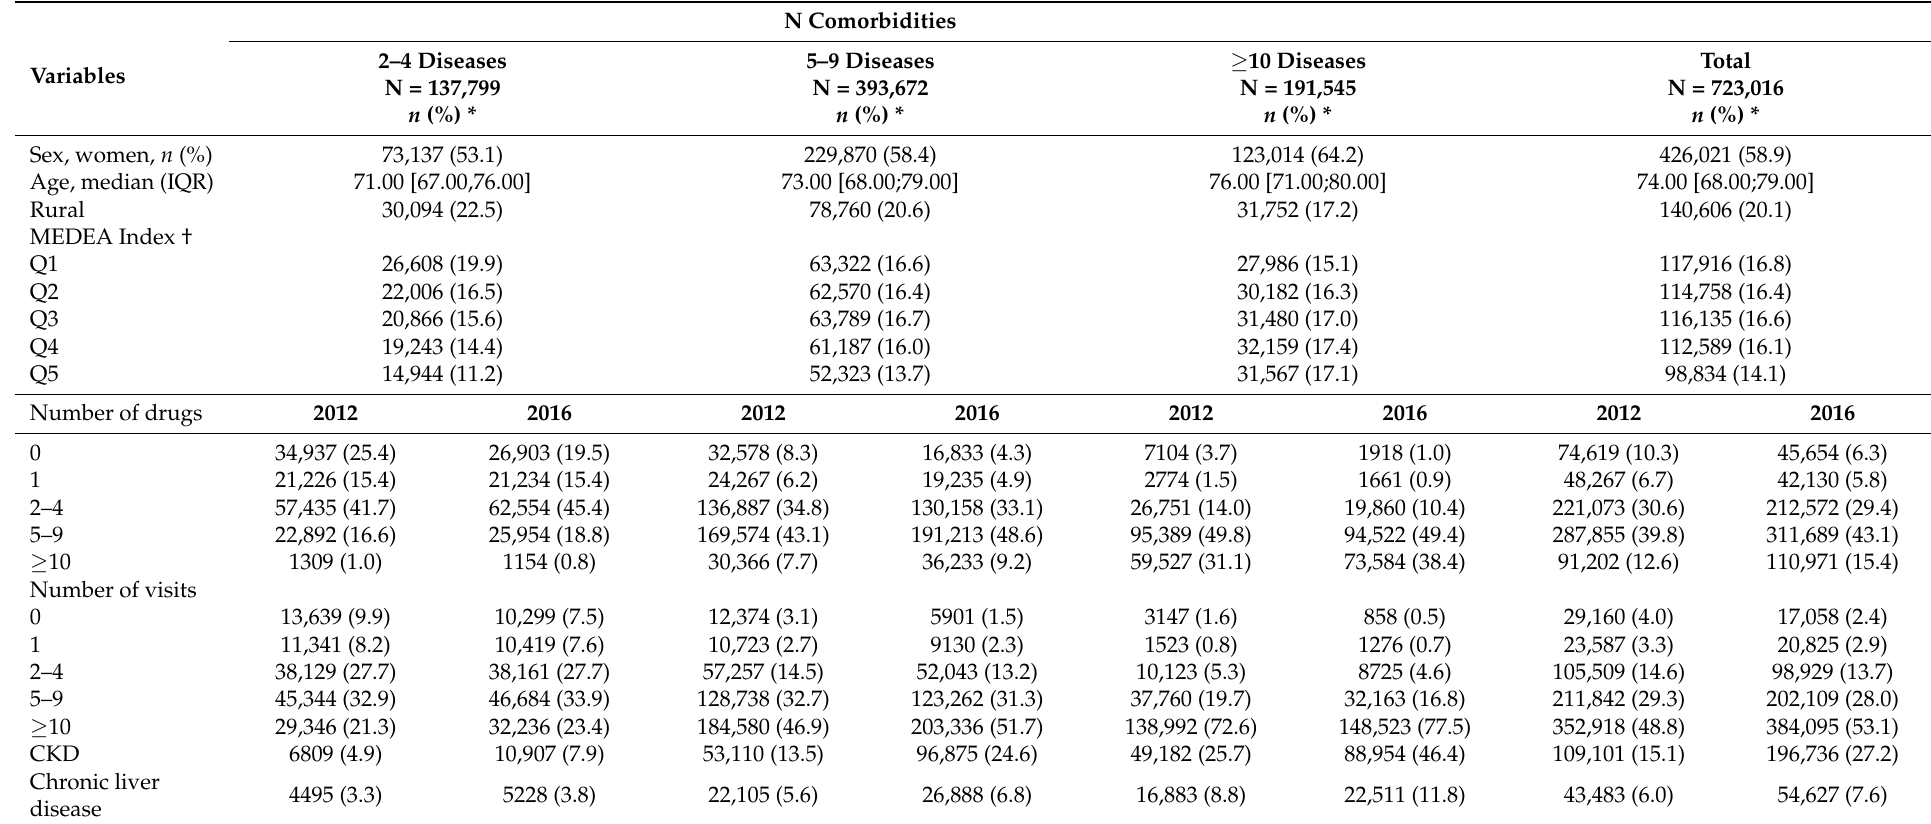
Table 1. Descriptive characteristics of older people by multimorbidity groups at baseline and at the end of the study (N =